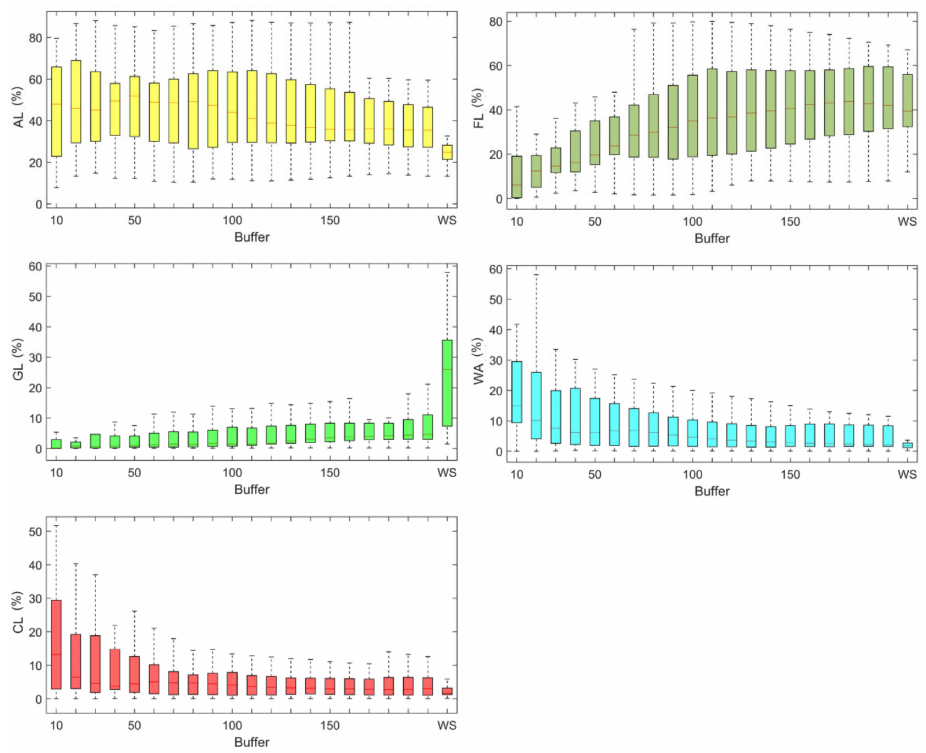
Figure 10. Box plot of 18 sites with different land use ratios in each buffer zone in